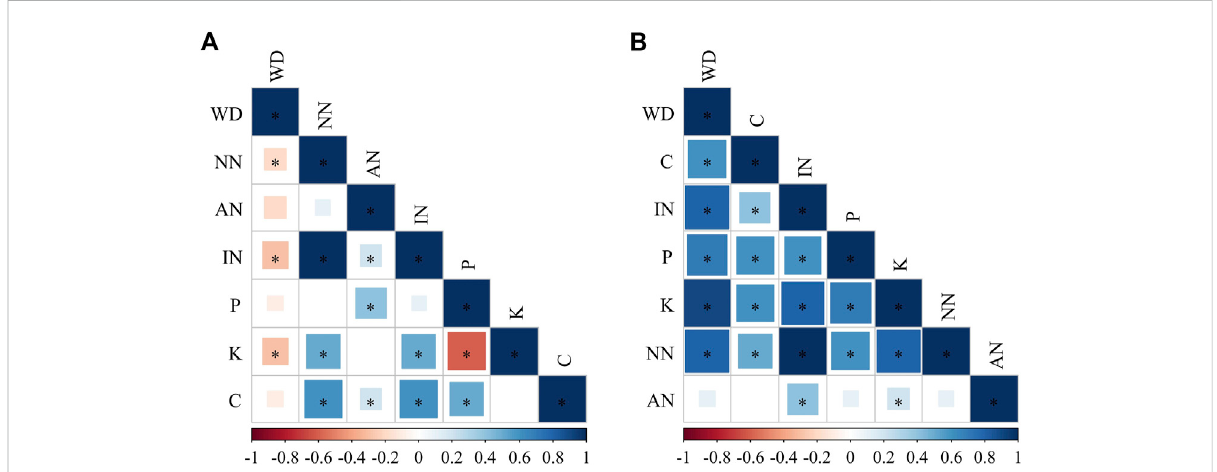
FIGURE 3 Relationships between groundwater depth and soil nutrients. Abbreviations of variables: WD, groundwater depth; C, soil organic carbon; NN, soil nitrate-N; AN, soil ammonium-N; IN, soil inorganic-N; P, soil available phosphorus; K, soil available potassium. (A) Relationships between groundwater depth and soil nutrients in the shallow groundwater; (B) Relationships between groundwater depth and soil nutrients in the deep natural groundwater. * indicates the correlation was signi fi cant at a 0.05 level.